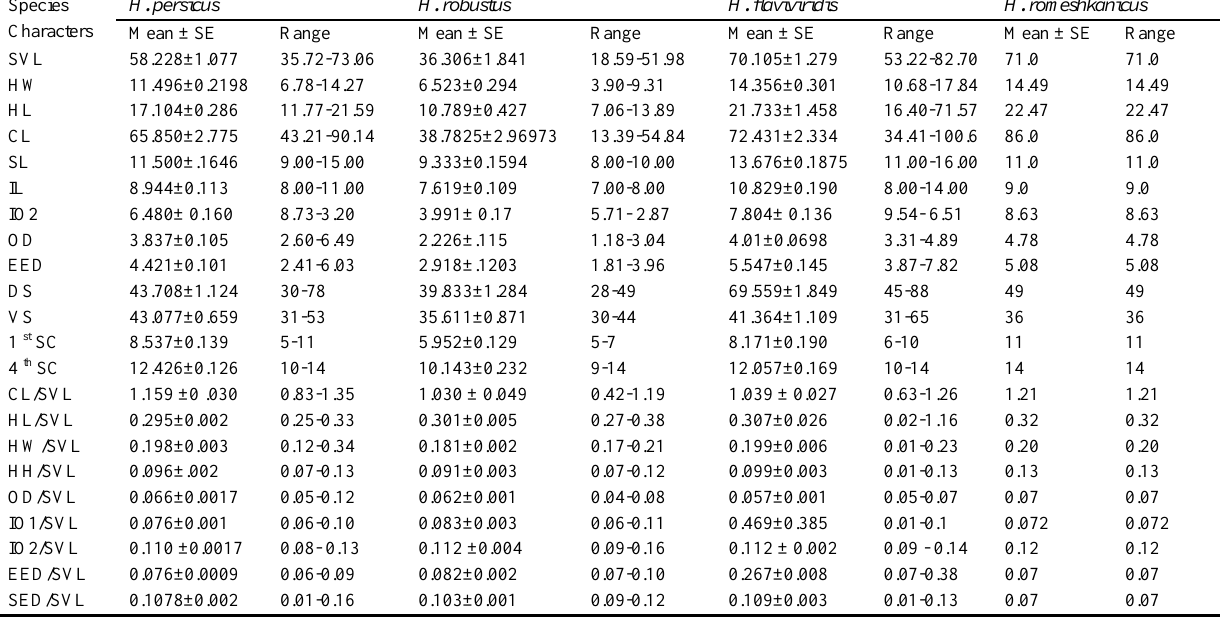
F IGURE 3. Canonical variates analysis of 14 metric and six meristic characters of Hemidactylus . Graph A and B parts belong to metric and meristic characters, respectively. T ABLE 3 . Descriptive parameters of meaningful 14 metric and six meristic characters in the studied species of the genus of Hemidactylus